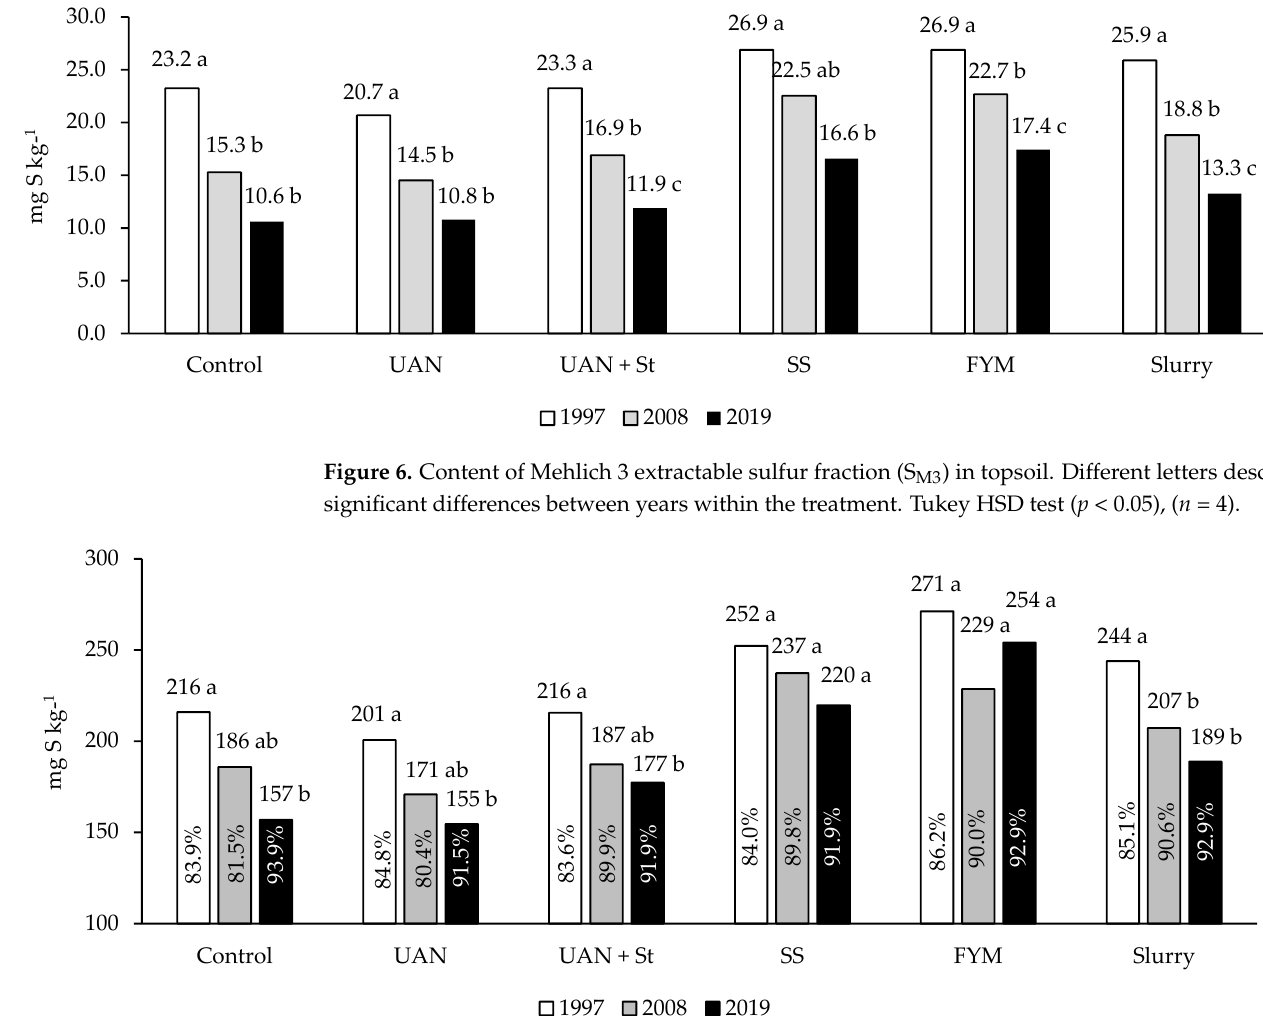
Figure 5. Content of available sulfur fraction (S av ) in topsoil. Different letters describe significant differences between years within the treatment. Tukey HSD test ( p < 0.05), ( n = 4).